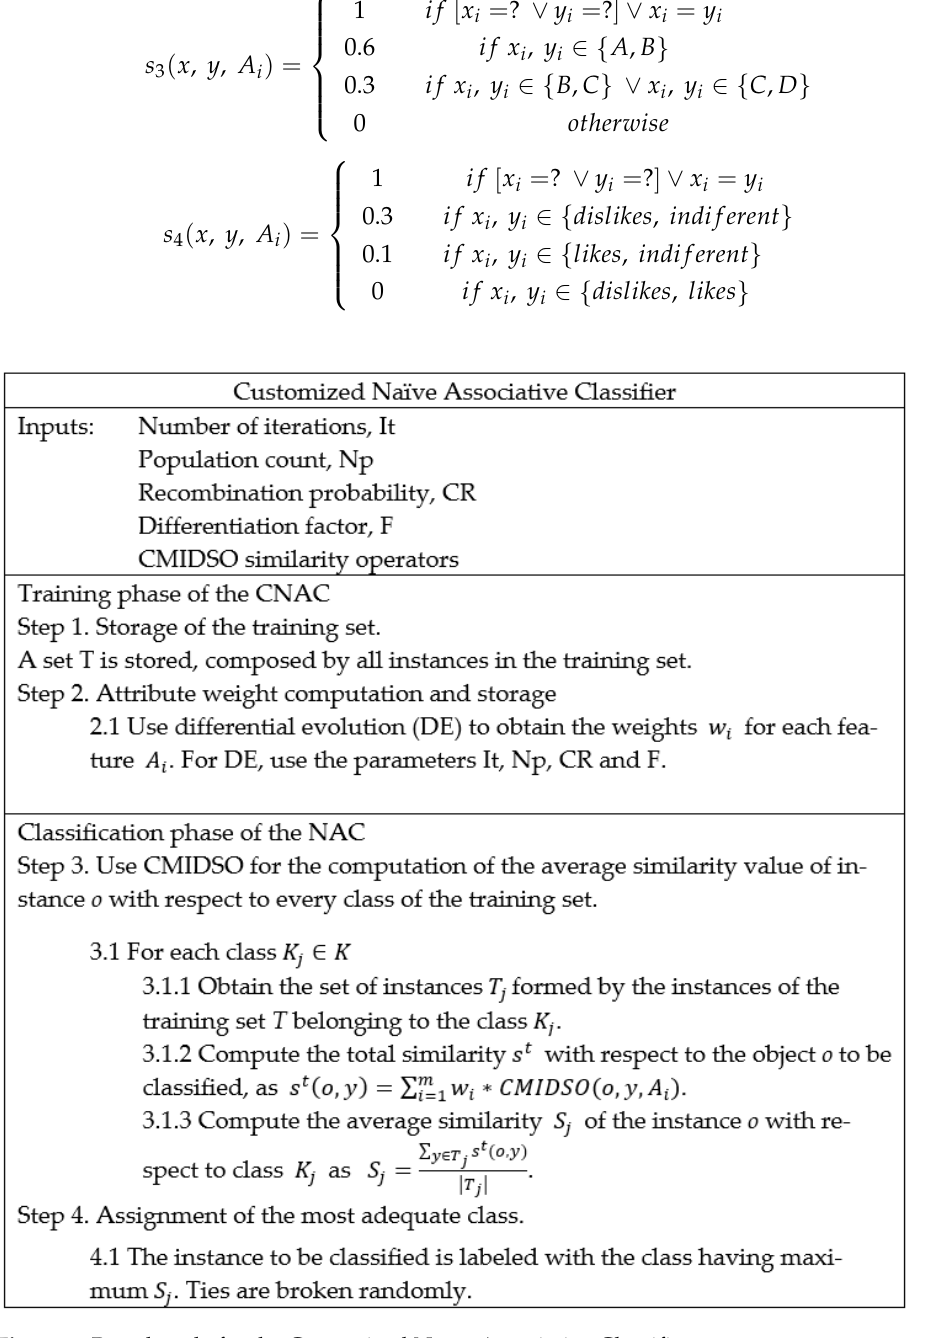
Figure 6. Pseudocode for the Customized Naïve Associative Classifier.